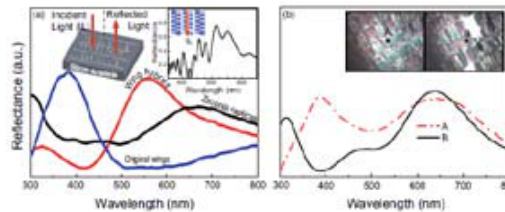
Fig. 9 Reflectance results of butterfly wings and ZrO 2 replicas. (a) Reflectance spectra of original but- terfly wings, wing hybrids (soaked wings after vacuum annealing), and ZrO replicas, respec- 2 tively. Insets show a schematic of the reflection measurement setup and the FDTD simulation results. (b) Reflectance spectra of (a) the over- lapped scales and (b) one single scale of ZrO 2 replica. Insets are the opticalimages of the mea- sured